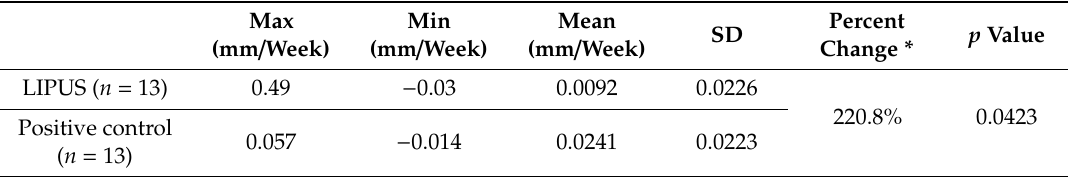
Figure 5. Comparison of the weekly rate of root resorption in the active group. Table 3. Comparison of the weekly rate of root resorption between the LIPUS and positive control side in the split-mouth group.